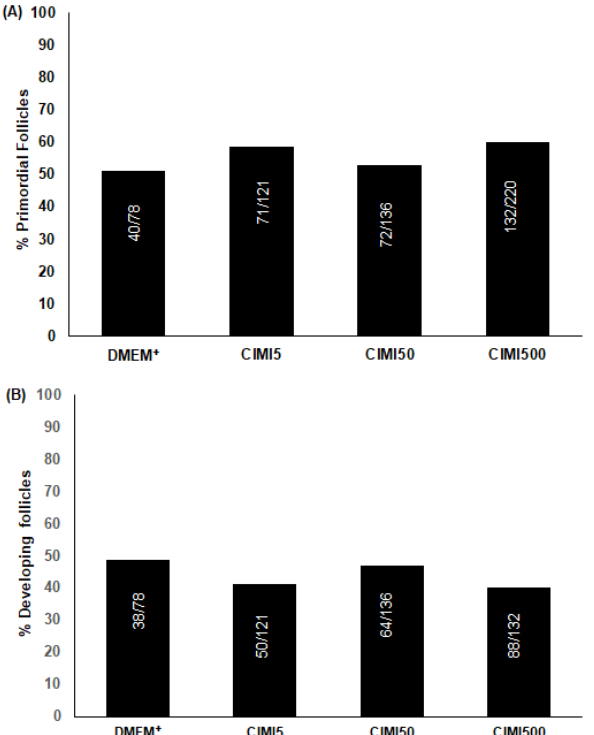
Figure 2. The percentage (mean ± SE) of primordial follicles ( A ) and developing follicles ( B ) in ovaries cultured for 6 days in DMEM + alone or with CIMI at different concentrations (5 ng/mL, 50 ng/mL or 500 ng/mL). The percentage of primordial and developing follicles was compared by chi-square test and no significant differences were observed between treatments ( p > 0.05). Numbers of follicles evaluated are shown within each column.